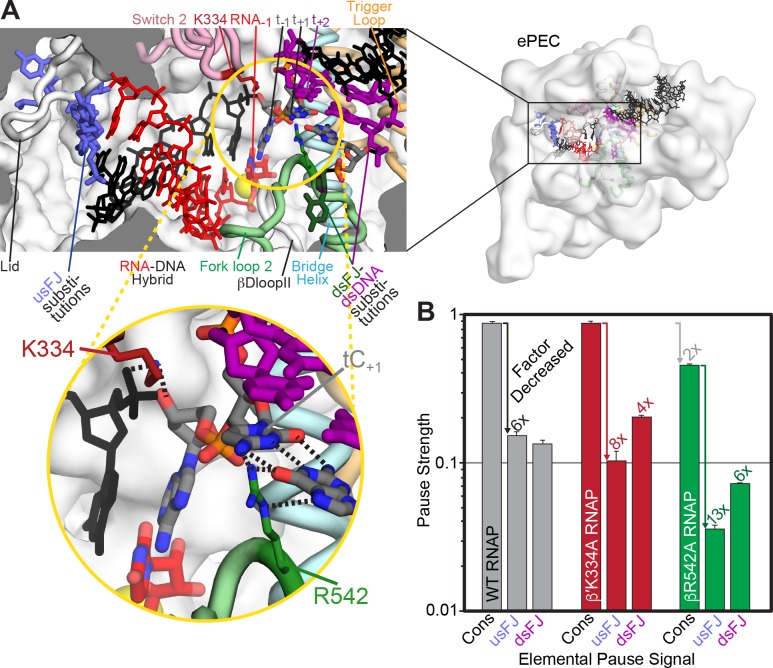
β R542 in fork-loop two may contribute to a template base loading barrier in ePEC.(A) Locations of β′K334 and βR542 in the ePEC. Relevant components of the ePEC are colored and labeled in a cutaway view of the active-site region of the ePEC. (B) Relative pause strength (PSP, Figure 2B) for wild type, β′K334A, and βR542A RNAPs on the consensus pause scaffold (Cons), the usFJ mutant scaffold, and the dsFJ mutant scaffold (see Figure 2A). The factor decrease relative to the wild-type RNAP on the consensus pause scaffold or relative to the consensus pause for the different RNAPs is given above the bars and depicted using colored arrows. Error is SD from ≥3 replicates.10.7554/eLife.40981.019Figure 7—source data 1.Fraction C17 pause RNA for wild-type and mutant pause signals.